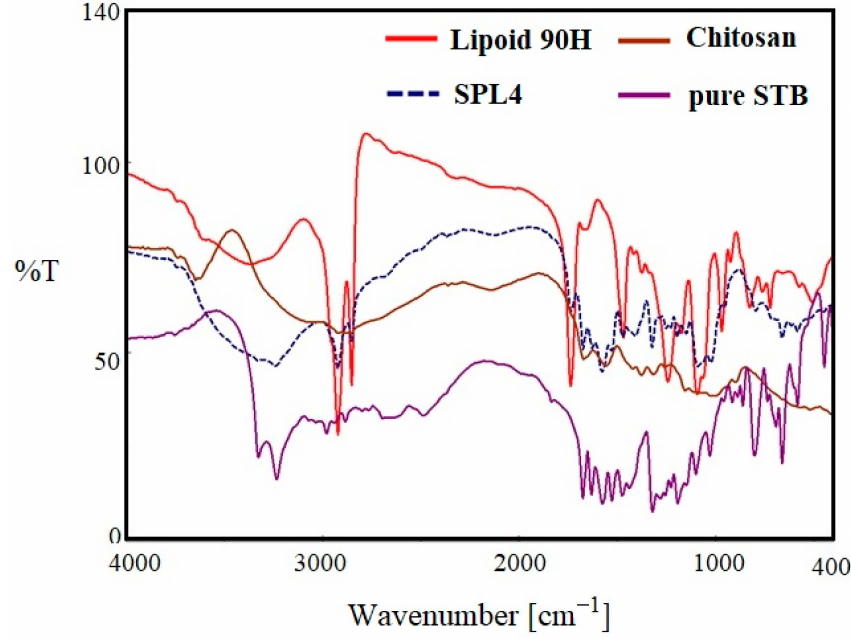
Figure 4. Comparative FTIR spectra of pure SM, SLPN4, lipoid 90H, and chitosan.